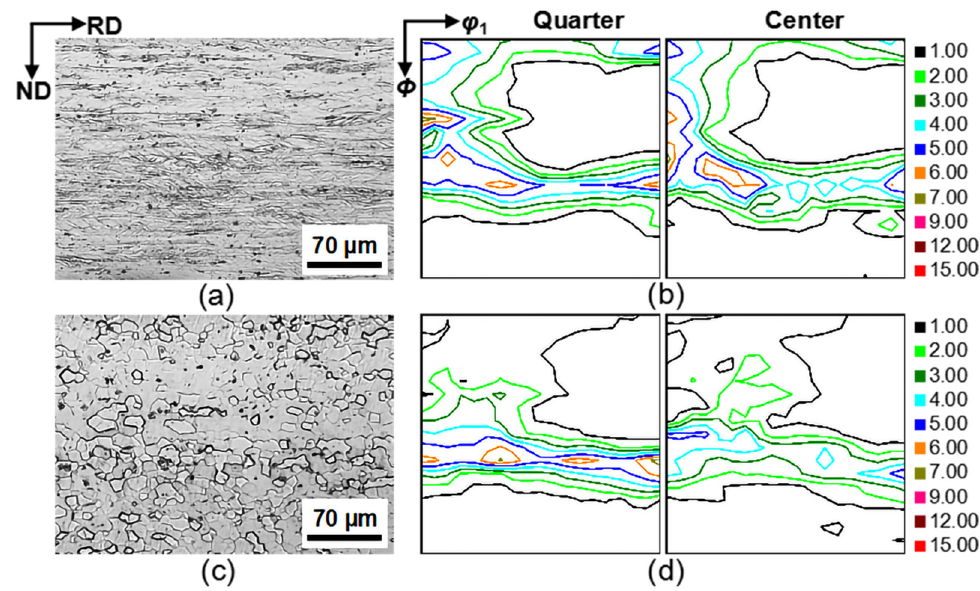
Figure 2. Microstructure ( a , c ) and φ 2 = 45° sections of ODFs ( b , d ) in ( a , b ) second-stage cold-rolled sheets and ( c , d ) primarily recrystallized annealed Fe 81 Ga 19 sheets.